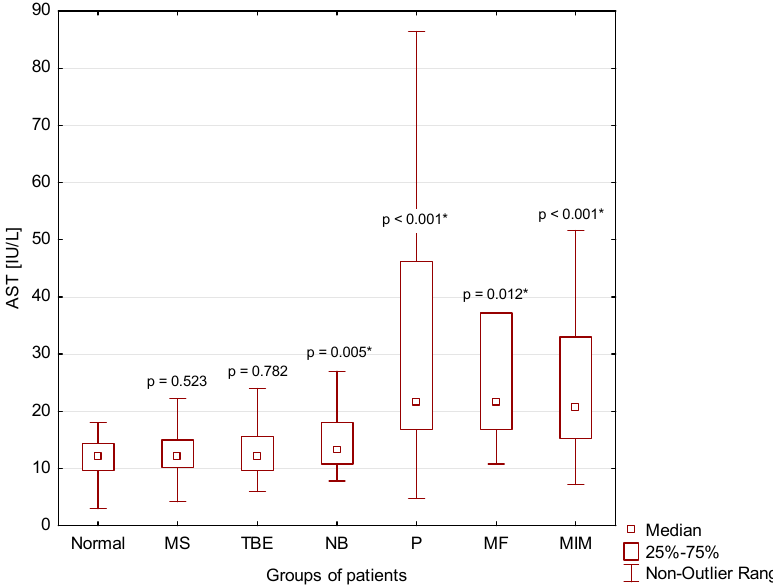
Figure 8. Catalytic activities of AST in CSF in our patient groups (*: statistically significant).